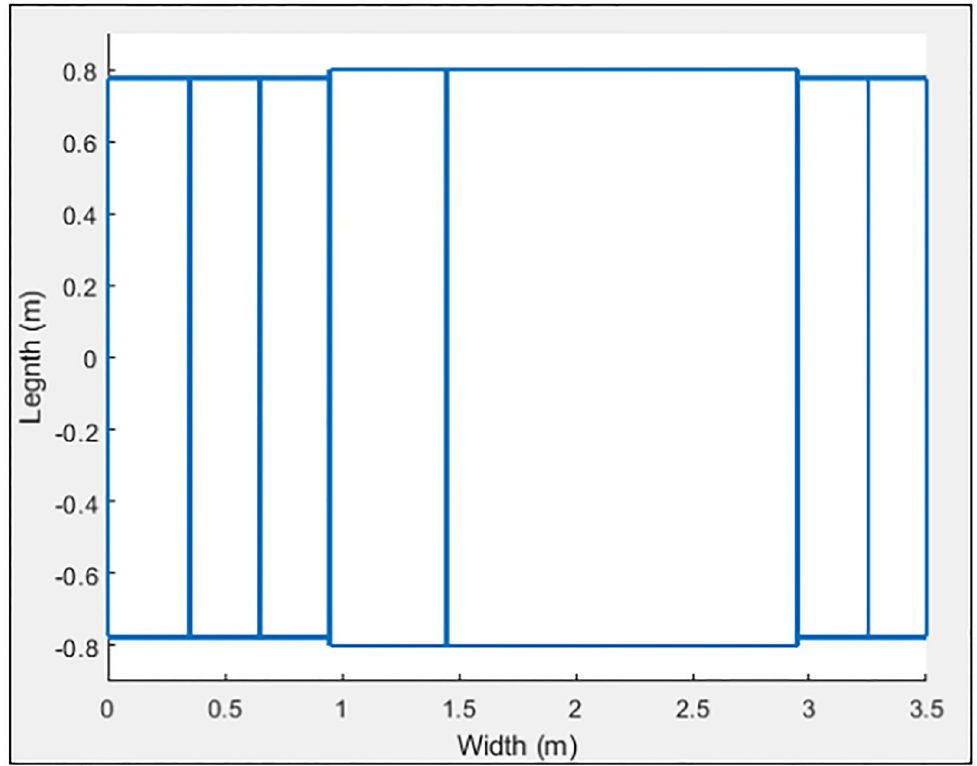
Fig 14. Citroe¨n AX characterized in 7